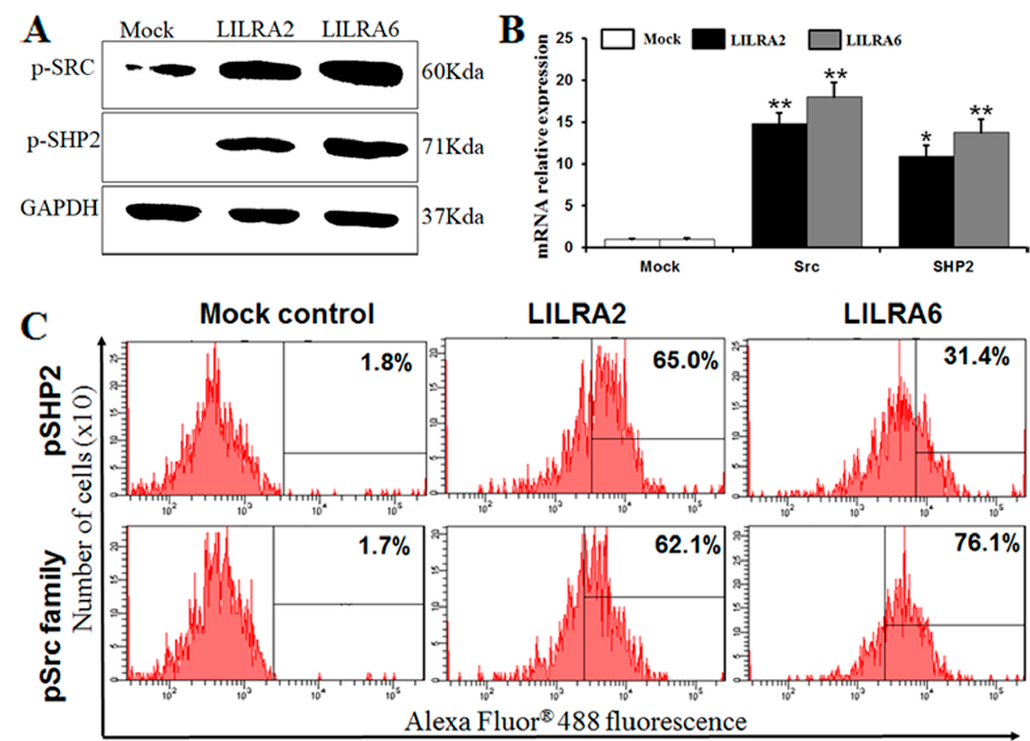
Figure 4. Chicken LILRA2 and LILRA6 are associated with phosphorylation of Src family and SHP2. ( A ) Western blot analysis for phosphorylated Src family members and SHP2 activated by LILRA2 and LILRA6 transfected in HD11 cells; ( B ) qRT-PCR analysis for Src1 and SHP2 mRNA transcripts